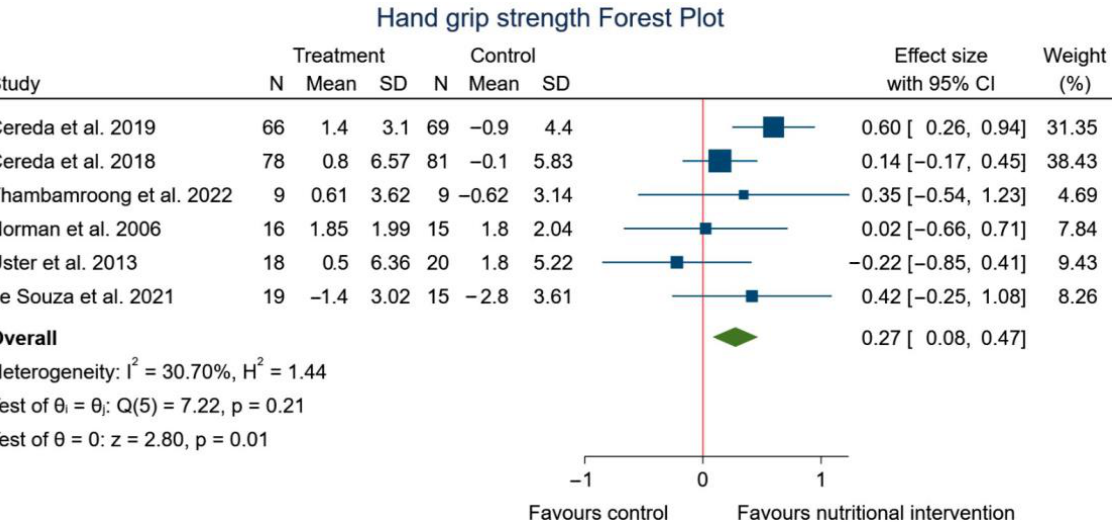
Figure 5. Forest plot summarizing the impact of nutritional intervention on handgrip using a fixed- effects model. Pooled summary data are presented as standardized mean differences and 95% confidence interval [39–41,53–55].